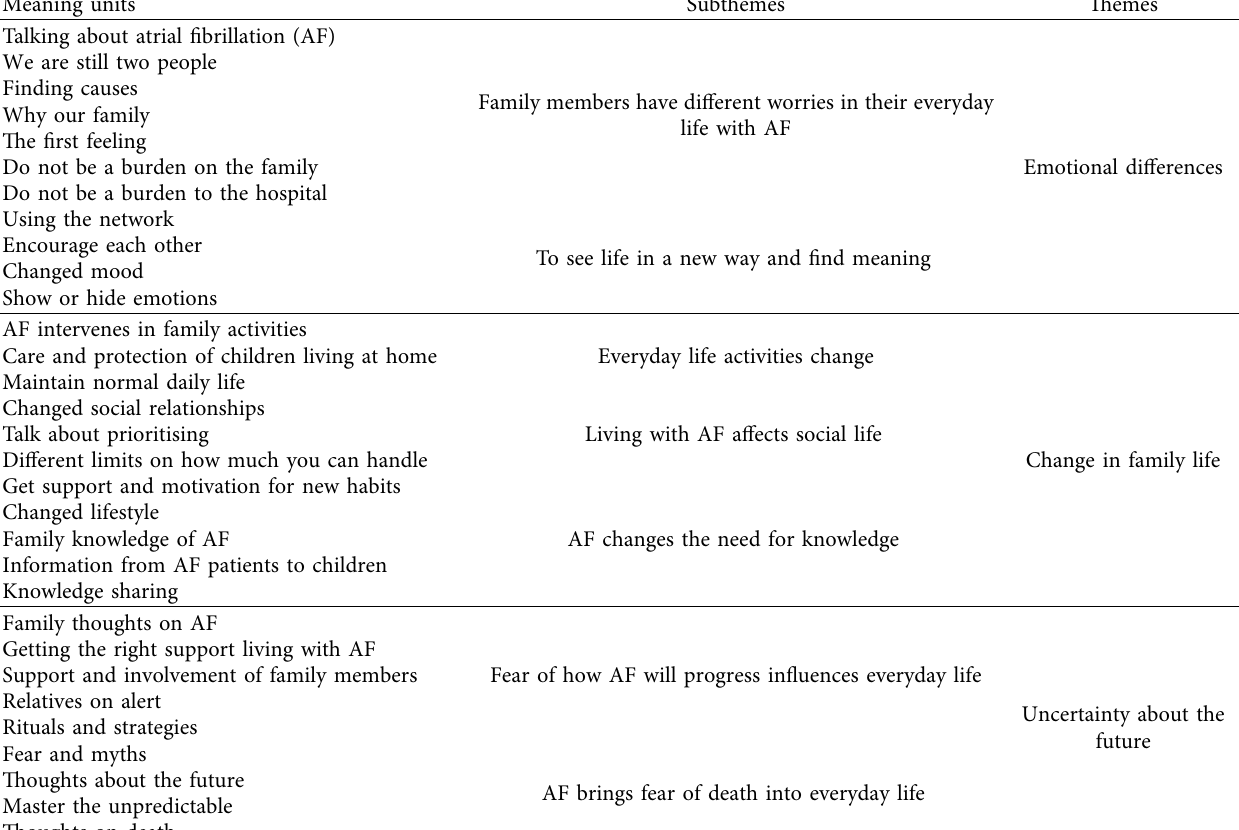
Table 2: Analysis process from derived meaning units to final